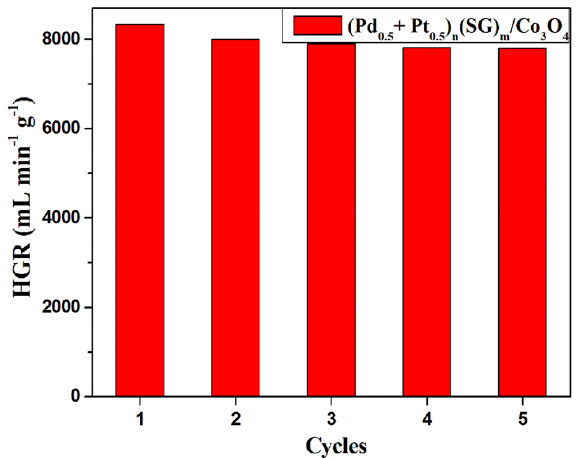
Figure 9. Recyclability of 1 wt.% (Pd 0.5 –Pt 0.5 ) n (SG) m /Co 3 O 4 catalyst for hydrogen generation from the hydrolysis of NaBH